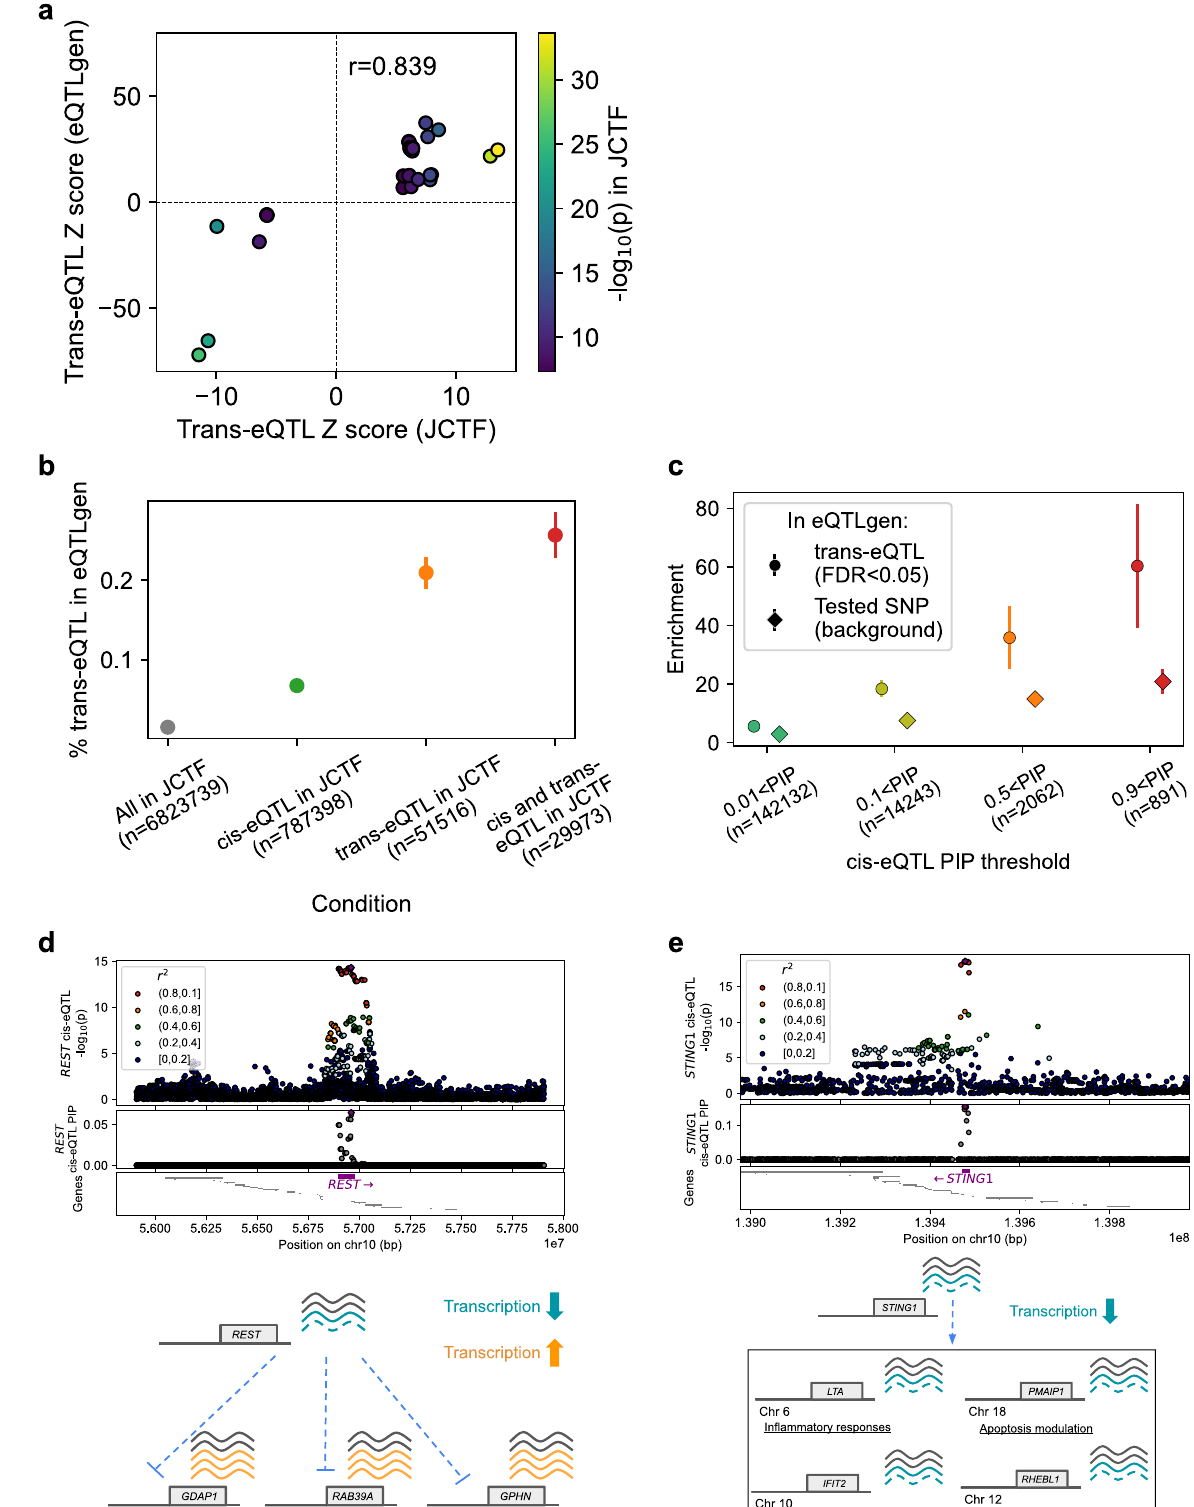
Fig. 5 | Insightsfrom trans-eQTL analysis.a Scatter plot showing the trans-eQTL effect sizes (z-score) in our analysis (x-axis) and in eQTLgen ( y -axis) for the 37 variant-genes identi fi ed as trans-eQTL both in two analyses. The color represents thenominalpvalueinouranalysis. b Percentageofvariantspresentingtrans-eQTL effectineQTLgen(FDR<0.05),forvariantsinourdatasetwithdifferentconditions ( x -axis). c Enrichment of variants presenting trans-eQTL effect in eQTLgen (circle)